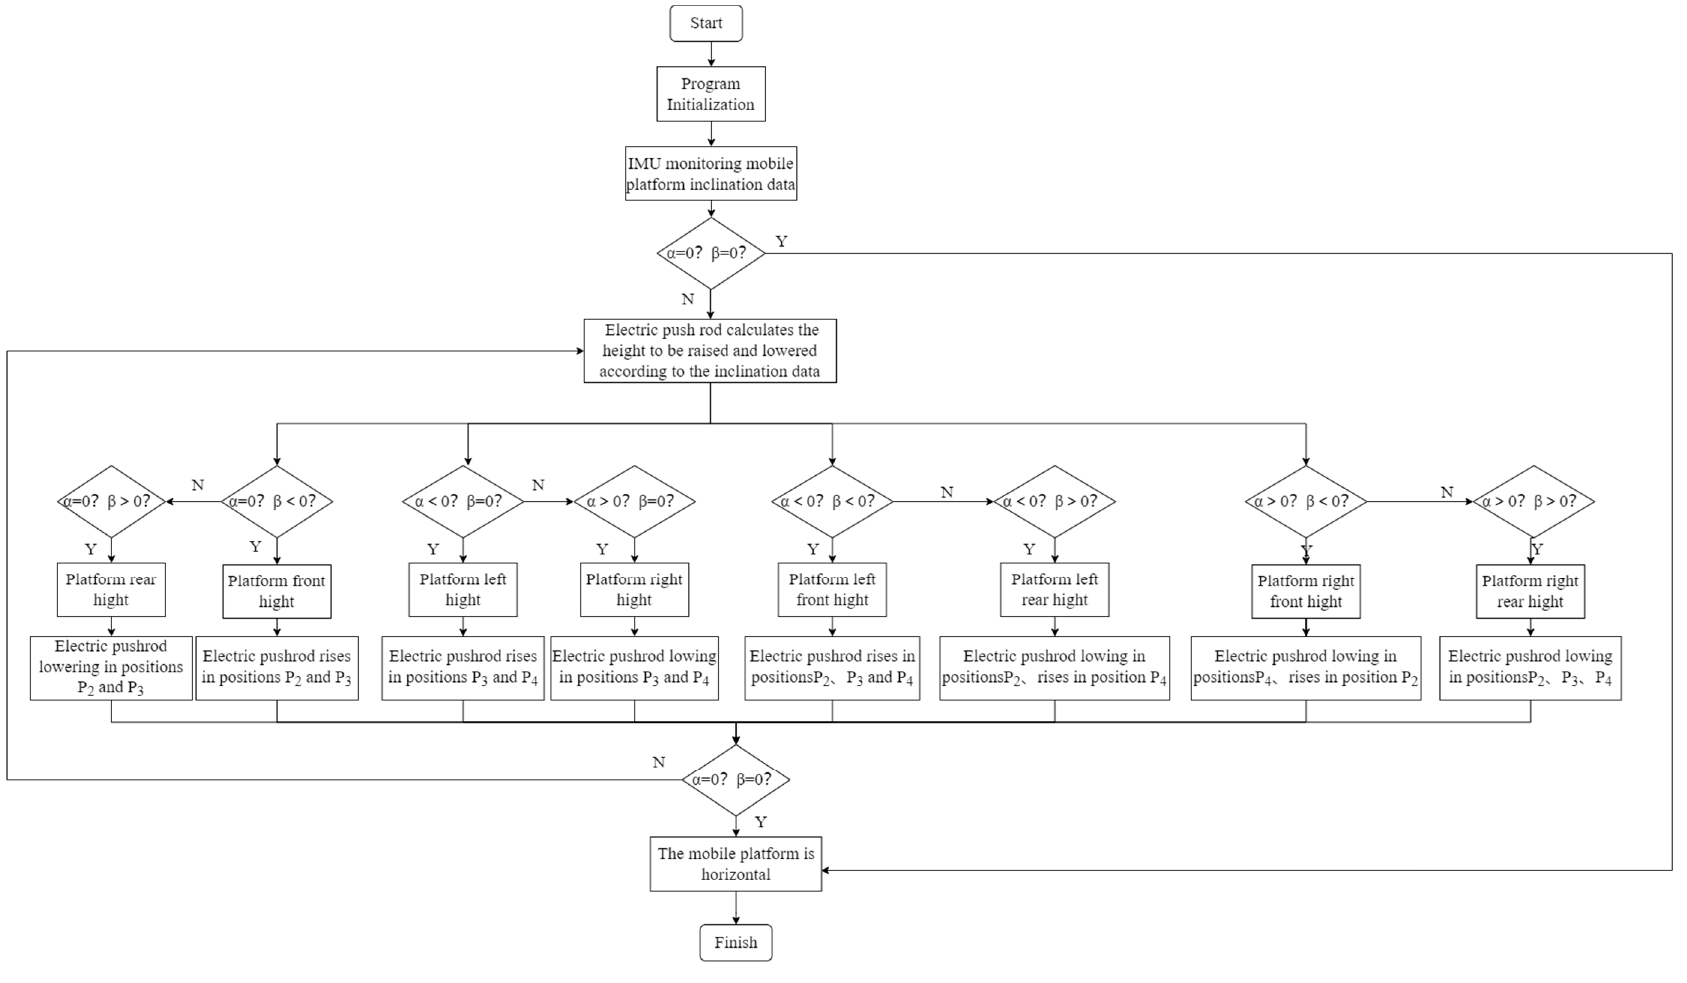
Figure 6. Levelling fl ow chart.